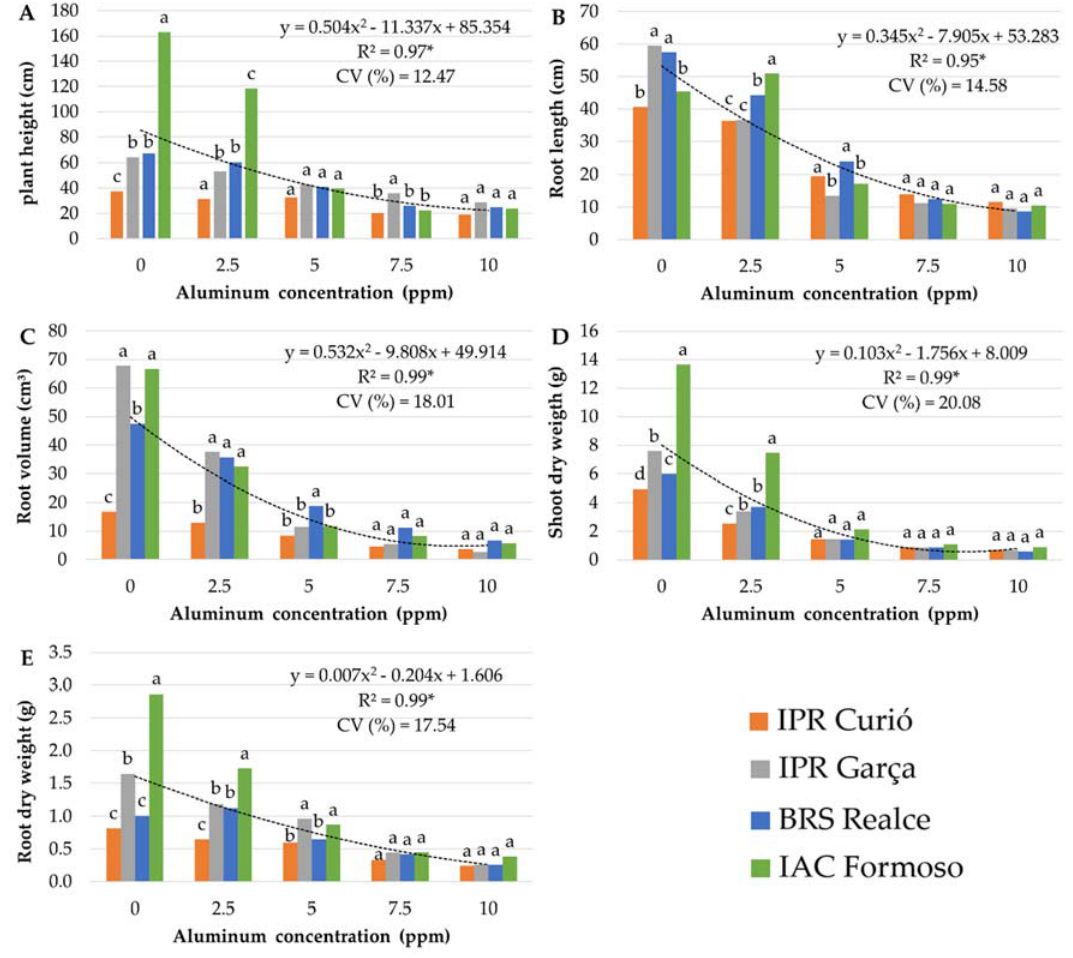
Figure 1. Response of morphological variables of common bean cultivars exposed to increasing Al concentrations in nutrient solution. ( A ) plant height (cm) (PH); ( B ) root length (cm) (RL); ( C ) root volume (cm 3 ) (RV); ( D) shoot dry weight (g) (DS); ( E ) root dry weight (g) (RD); CV (%) = coefficient of variation. Means followed by the same letter did not differ significantly between cultivars within each Al concentration by the Scott–Knott test ( p ≤ 0.05). * significant regression analysis at 5% probability.